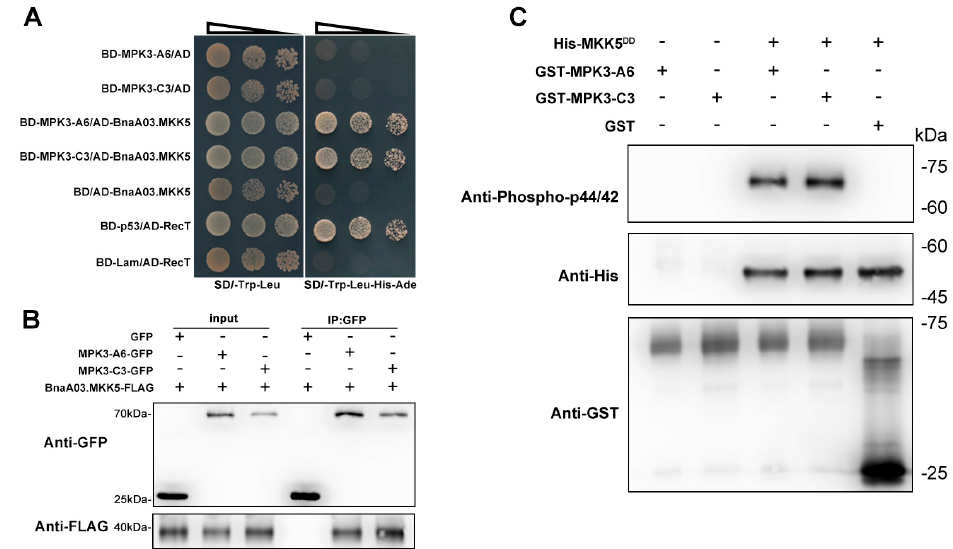
Figure 5. Identification of the interaction between BnaA03.MKK5 and BnaA06.MPK3/BnaC03.MPK3. ( A ) Yeast two-hybrid (Y2H) to detect the interaction between BnaA03.MKK5 and BnaA06.MPK3/BnaC03.MPK3. BD-p53/AD-RecT, positive control; BD-Lam/AD-RecT, negative control. ( B ) Co-immunoprecipitation (CoIP) assays to confirm the interaction between BnaA03.MKK5 and BnaA06.MPK3/BnaC03.MPK3 in planta. ( C ) In vitro phosphorylation detection of BnaA03.MKK5 on BnaA06.MPK3/BnaC03.MPK3. 2.5. BnaA06.MPK3/BnaC03.MPK3 Positively Contribute to S. sclerotiorum Resistance in B. napus